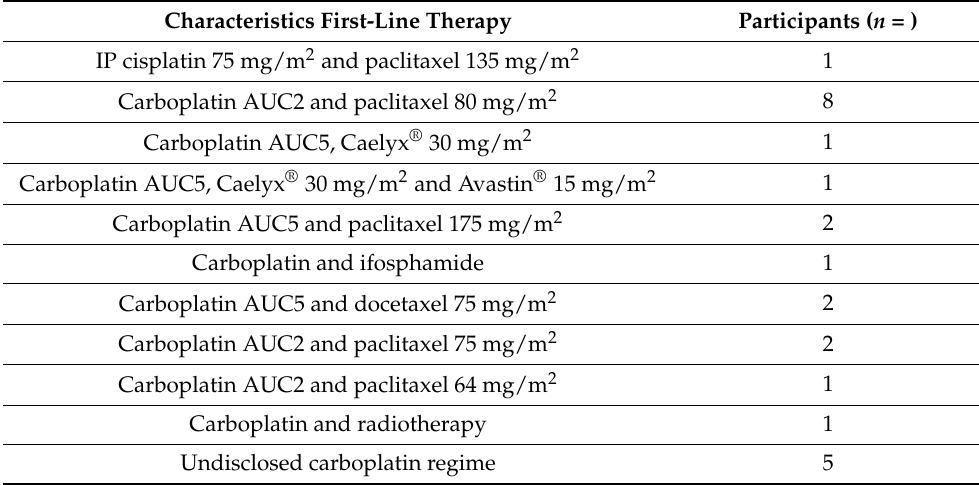
Table 2. Therapy Characteristics: Chemotherapy regimens in study